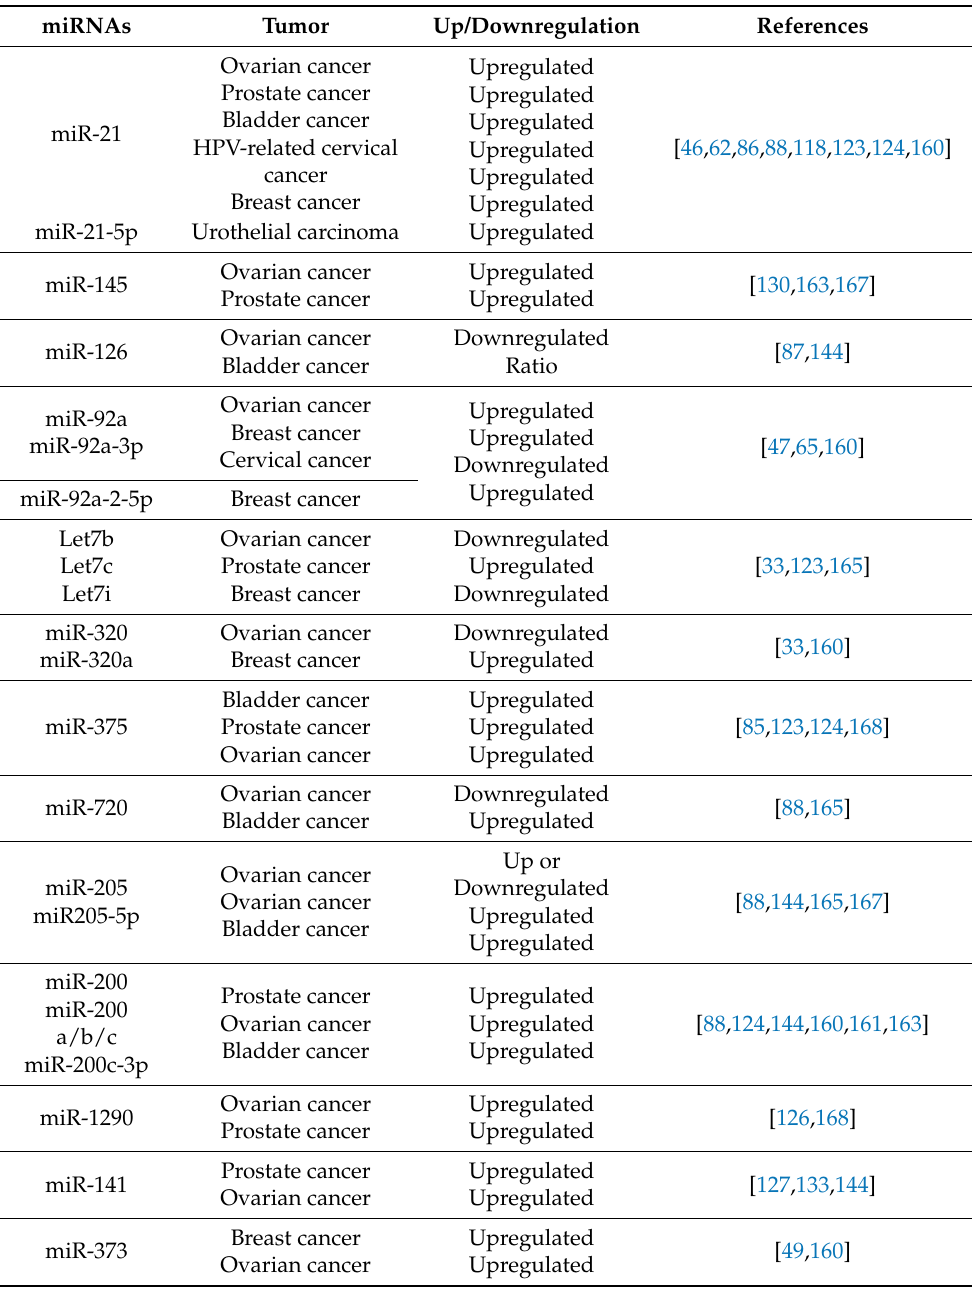
Table 7. EV-associated markers shared among different